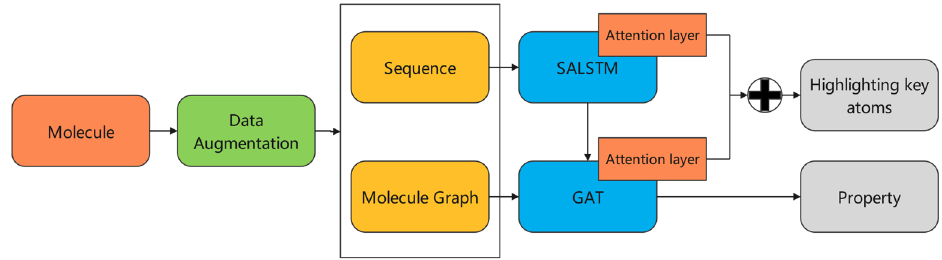
Figure 2. The overall framework.